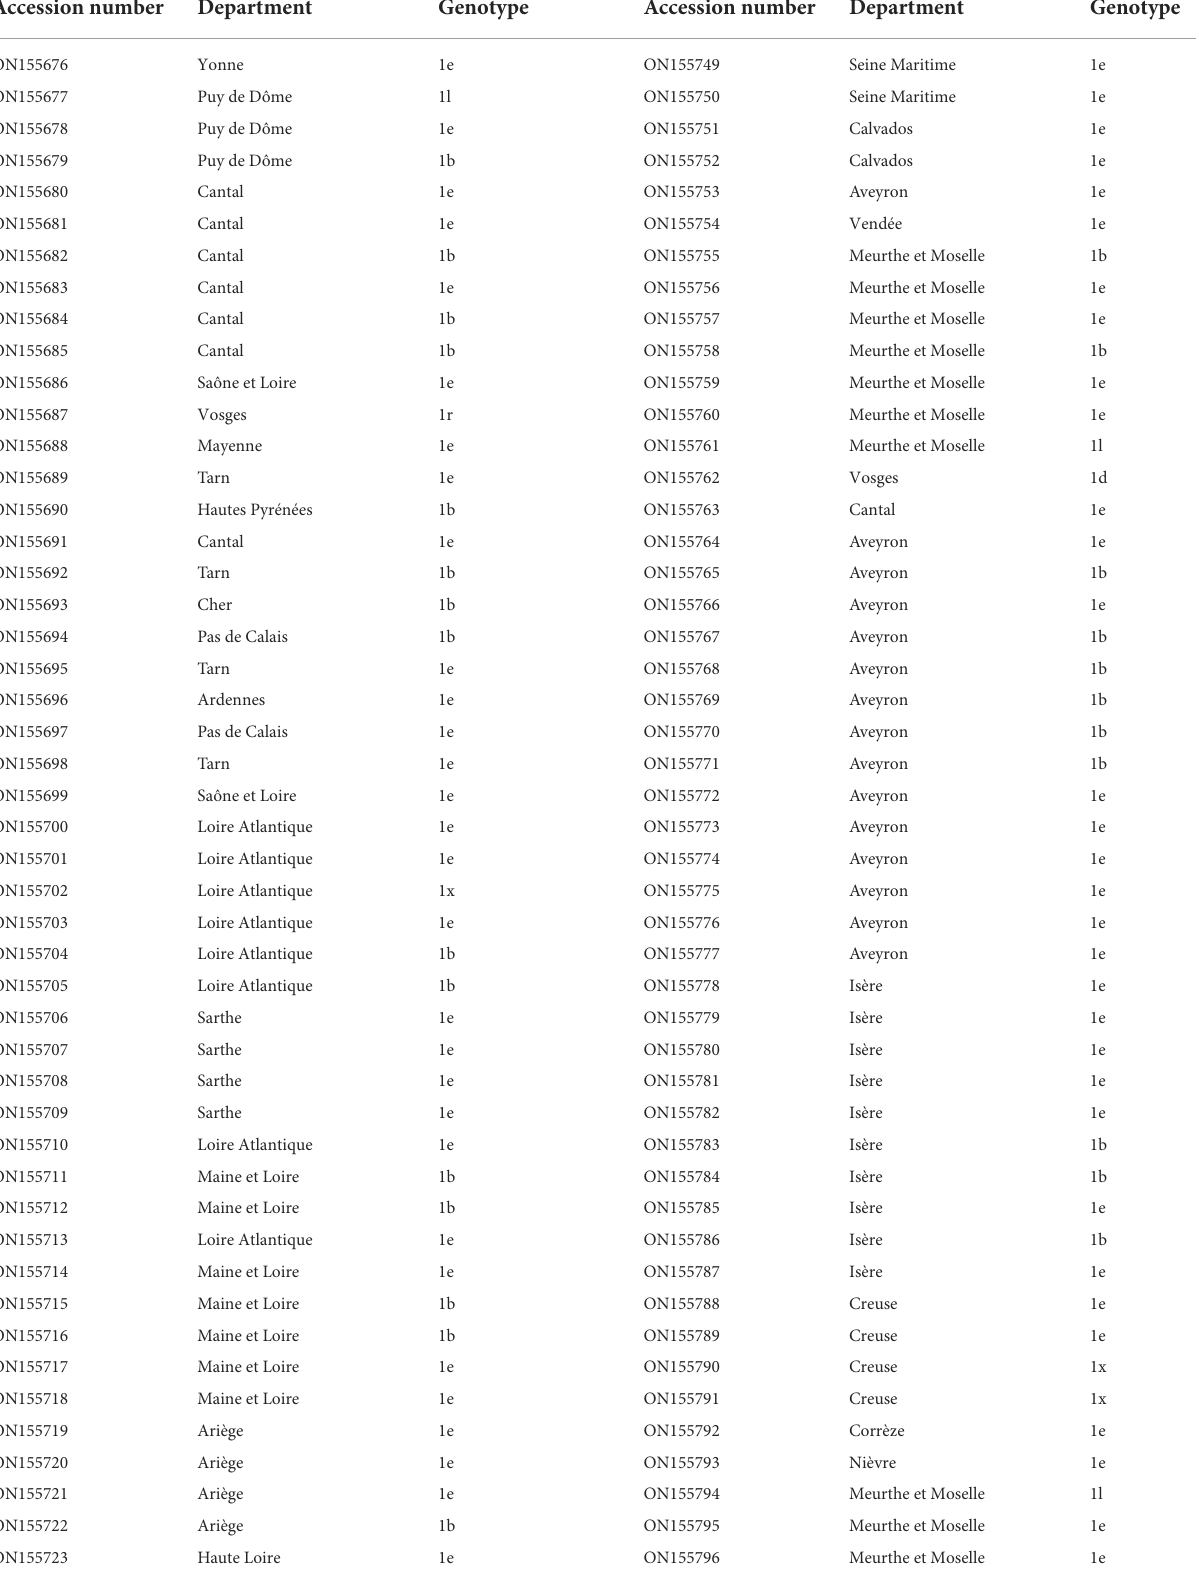
TABLE 1 List of field viral strains analyzed in this